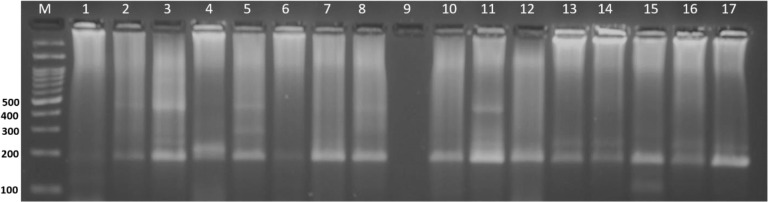
Representative nested Cp-PCR amplification products from the second PCR reaction.Positive samples show amplified products of 183 bp in lanes 1–8 and 10–16, lane 9: negative control, lane 17: positive control, and lane M: 100 bp DNA ladder.